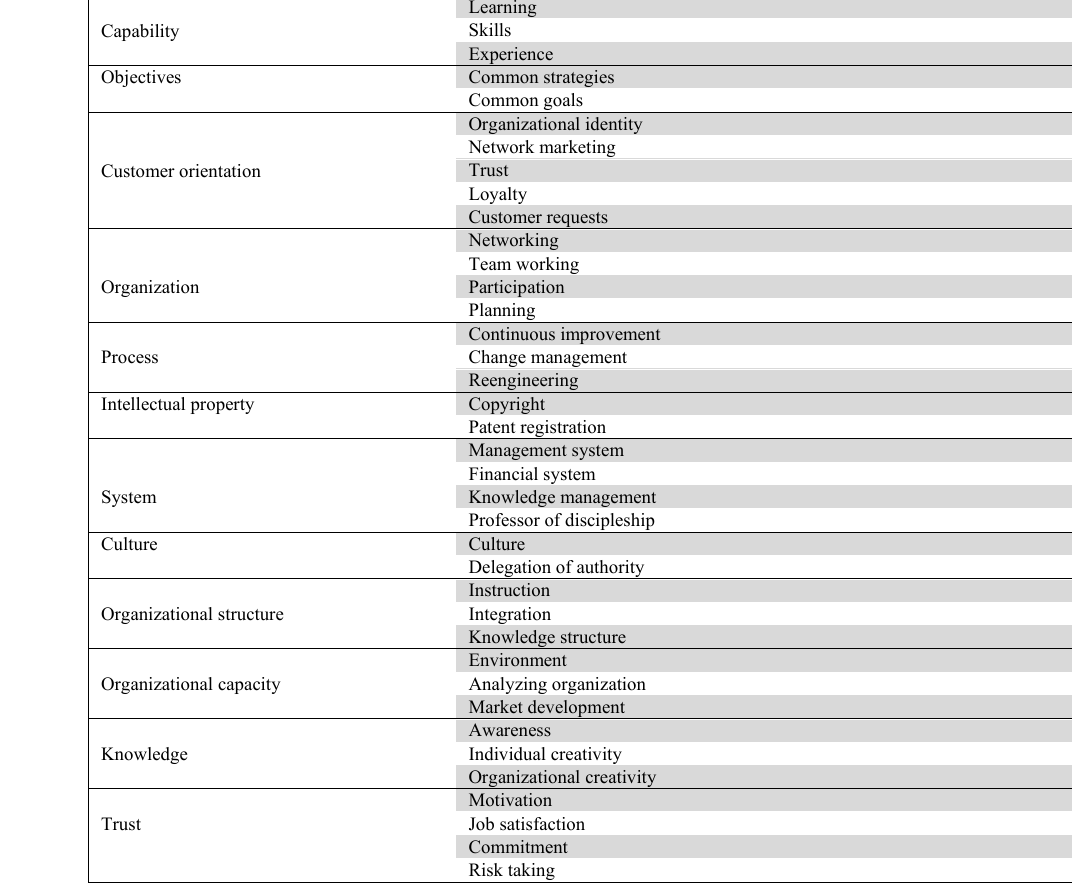
Fig. 1. The conceptual model